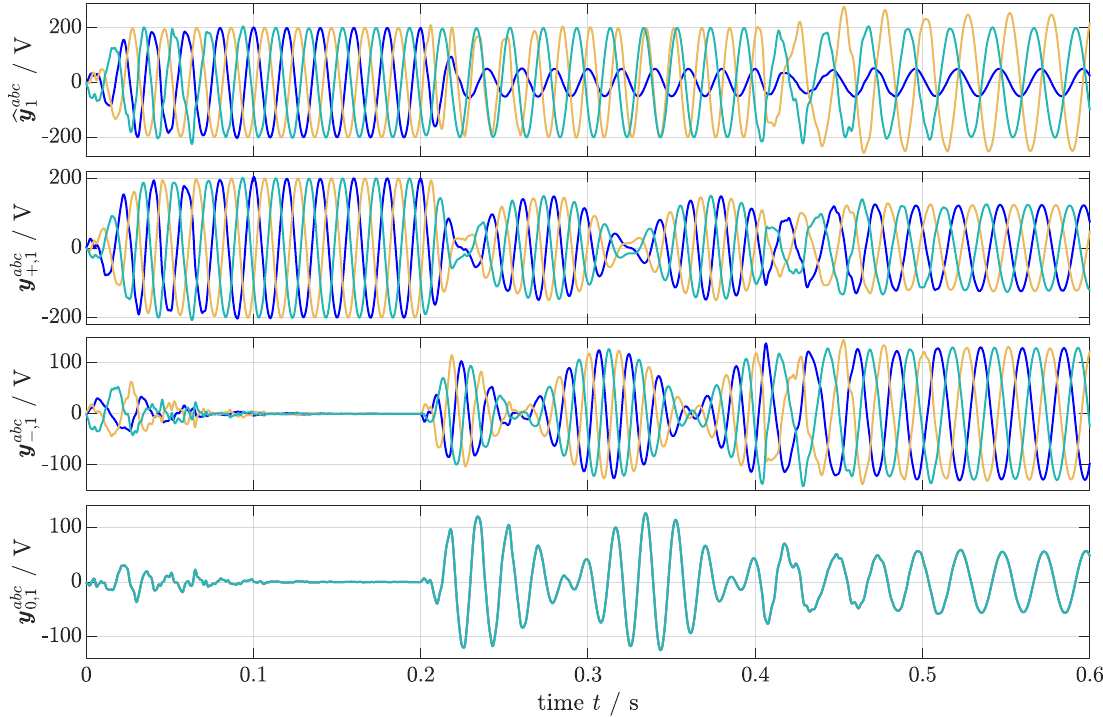
Figure 11. Simulation results for Scenario (S4): Estimated in-phase signals (cid:98) y abc y abc + y abc − ,1 , negative- ,1 and zero-sequence